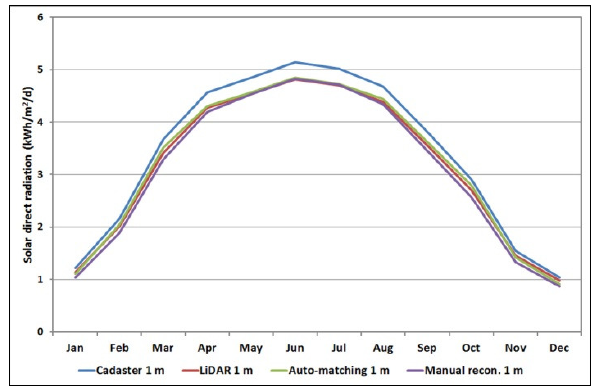
Figure 5 – Comparison between solar radiation results obtained from all rasters at 1 m resolution.